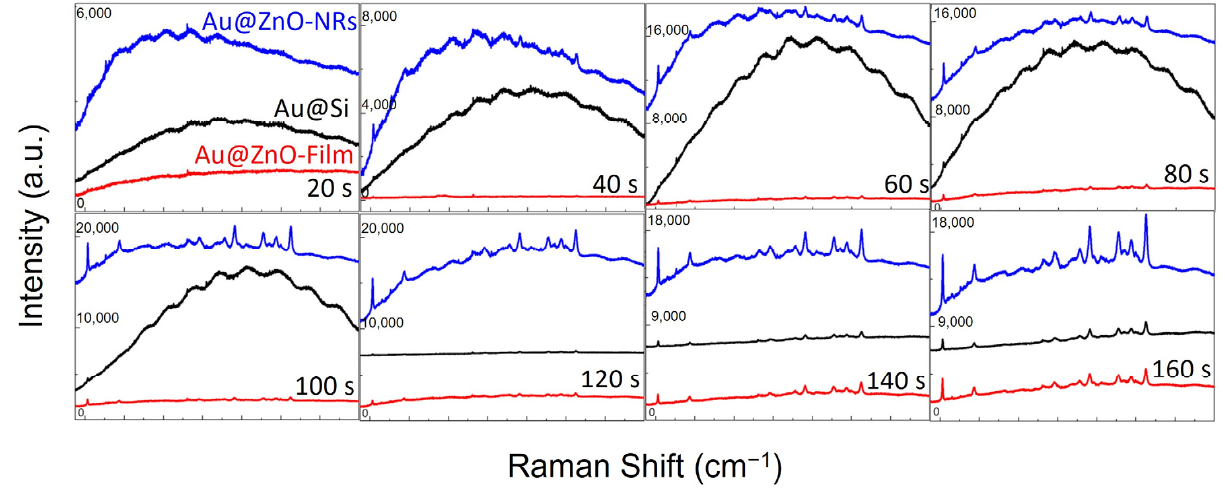
Figure 6. Raman spectra detected from three kinds of substrates with the same sputtering time.